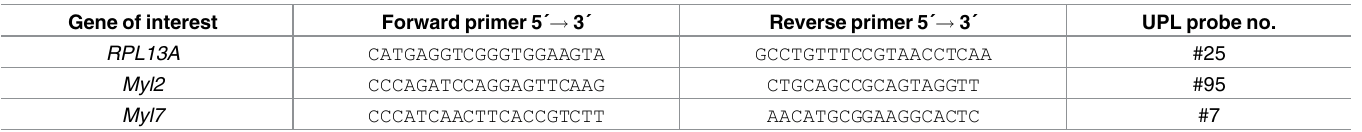
Table 2. Probes and sequences of primers used in quantitative RT-PCR. Gene of